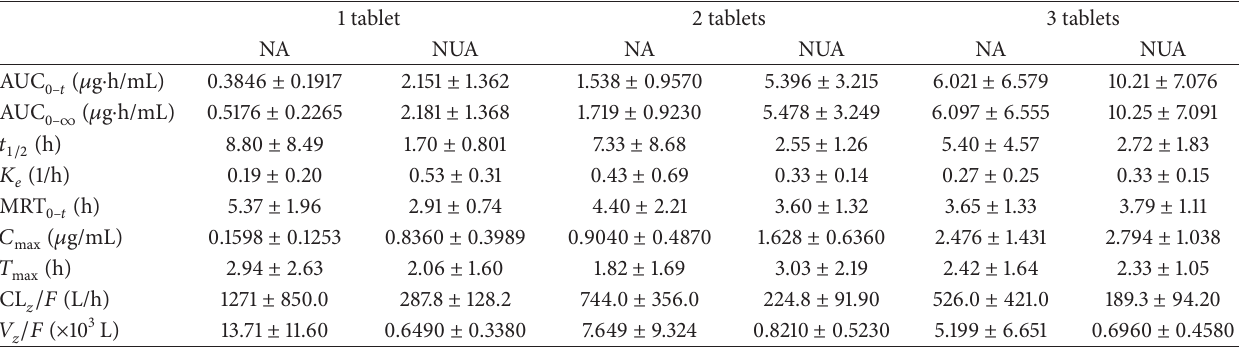
Table 4: The main pharmacokinetic parameters for NA and NUA after single oral doses of Niacin extended-release/Simvastatin to healthy volunteers (mean ± S.D., 𝑛 = 12